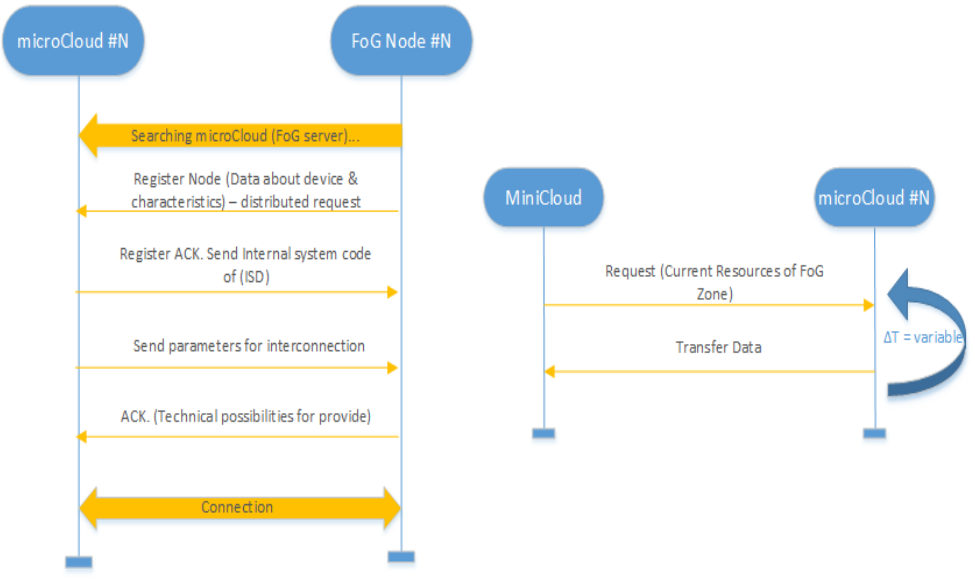
Figure 5. Diagrams of interaction of functional